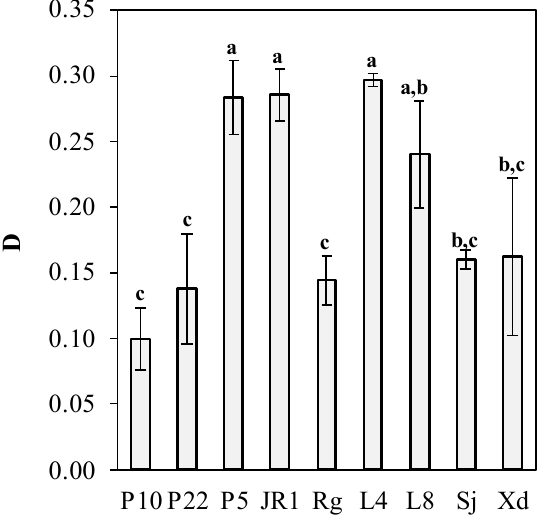
Figure 3. Oleaginous yeast global desirability on simultaneous carotenoids and microbial oil produc- tion performance. Significance difference ( p < 0.05) is marked with subscript letters a,b,c.